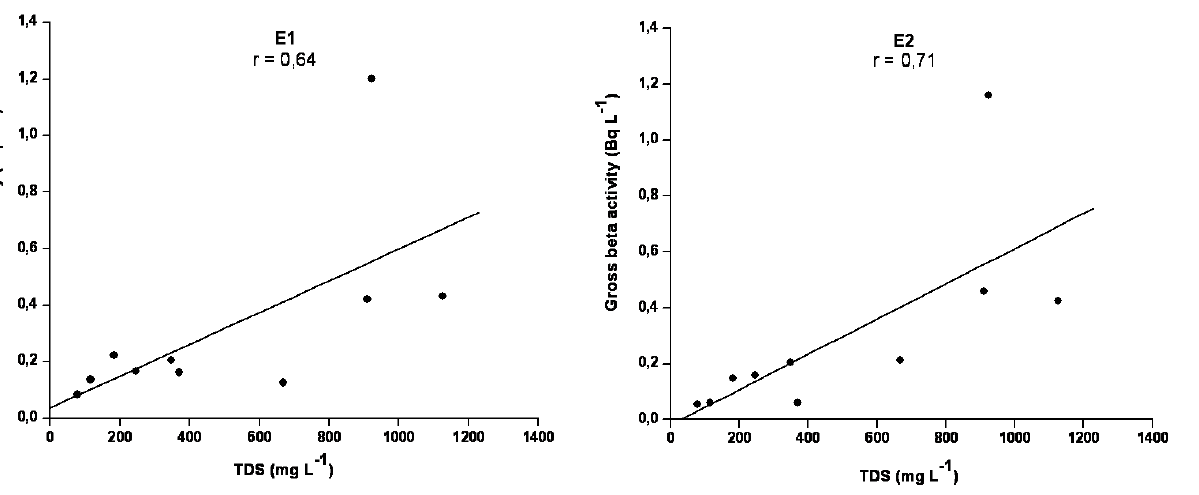
Figure 2 : Correlation between gross beta activity and the total dissolved solids using E2